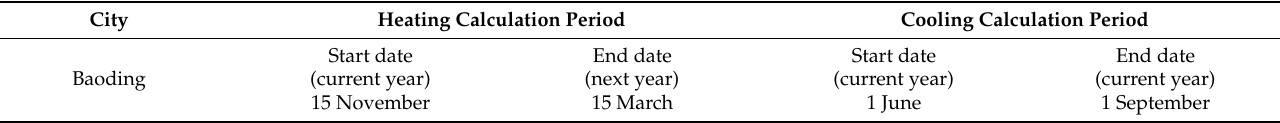
Table 1. Starting and ending time of heating and cooling.